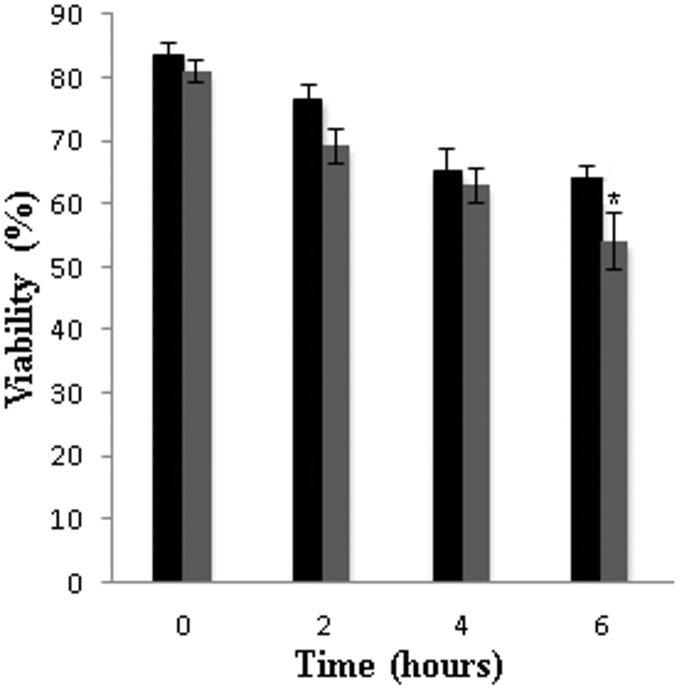
Effect of argentilactone on P. lutzii Pb01 yeast cells growth.Yeast cells were cultured at 36°C in the presence of argentilactone for 6 hours. Aliquots were taken and the cells were counted in a Neubauer chamber.*p<0,05.